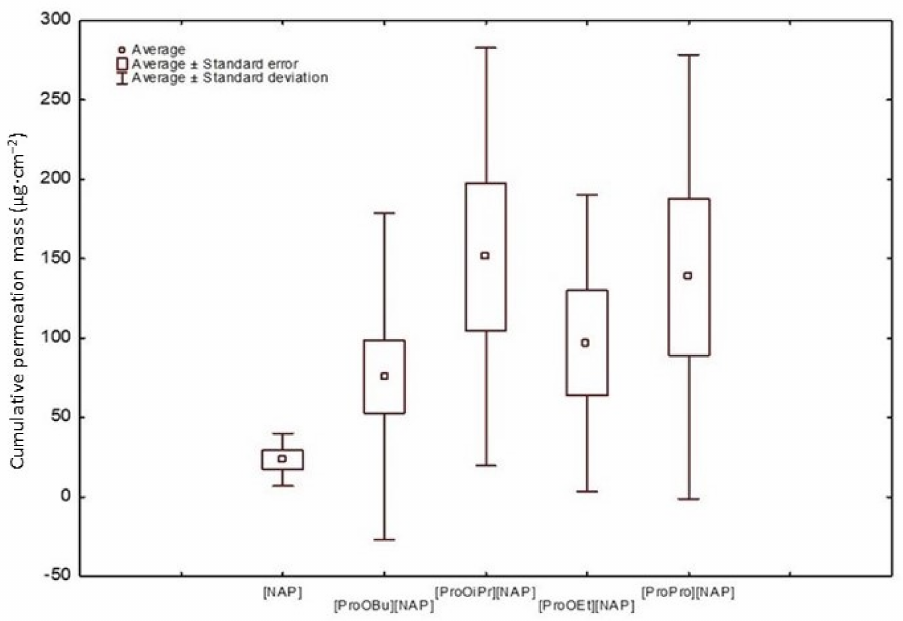
Figure 10. The box-plot of cumulative mass for naproxen and its derivatives after 24 h permeation.